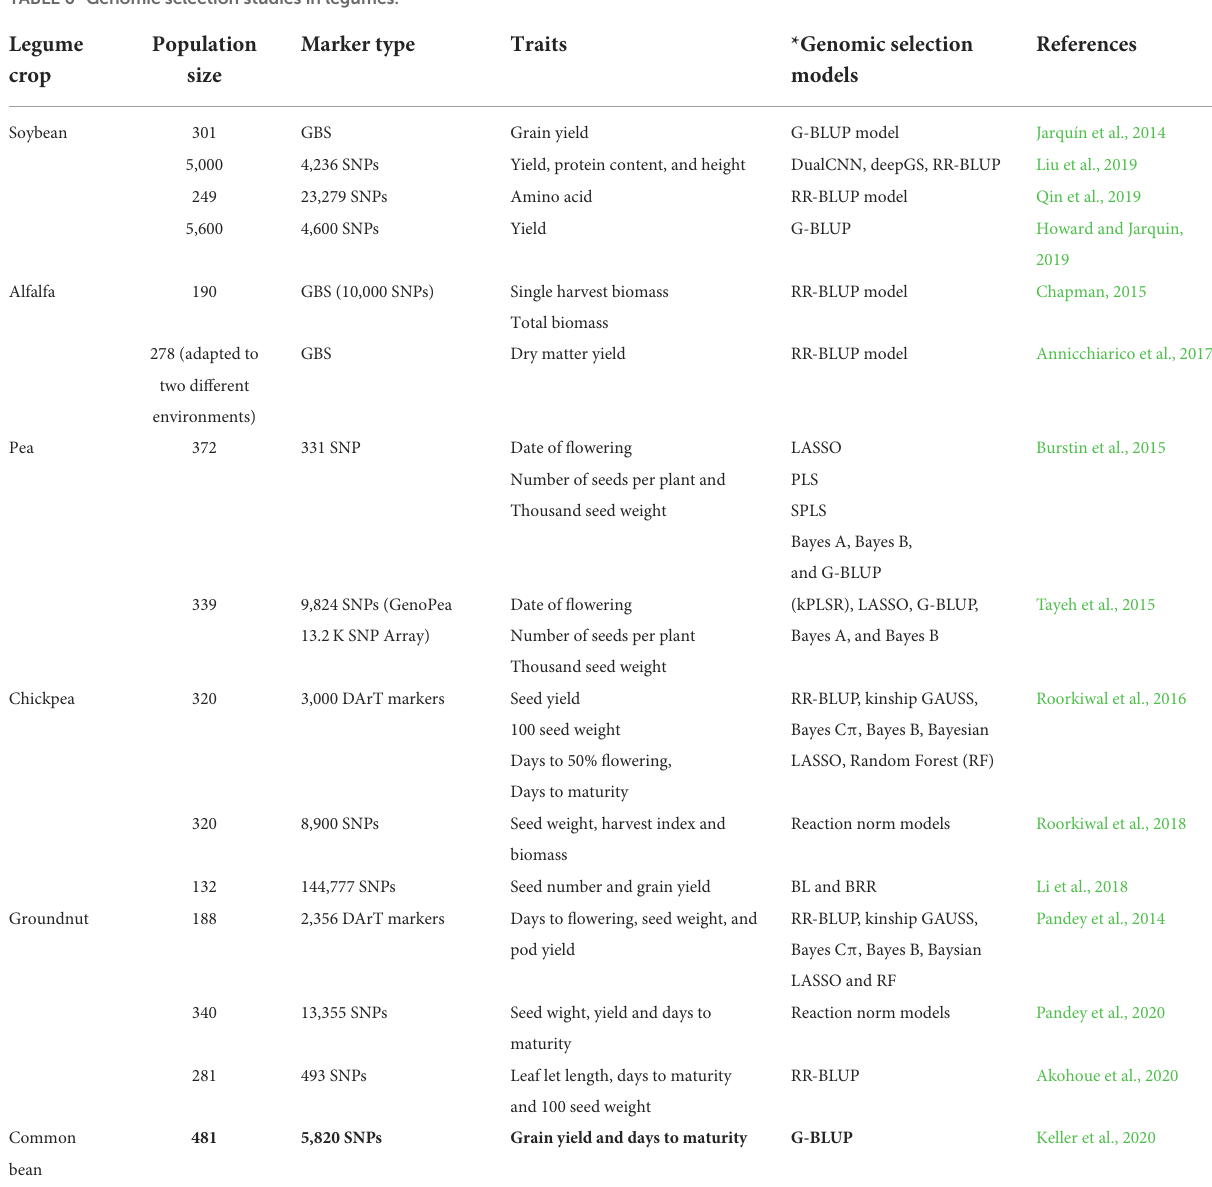
TABLE 6 Genomic selection studies in